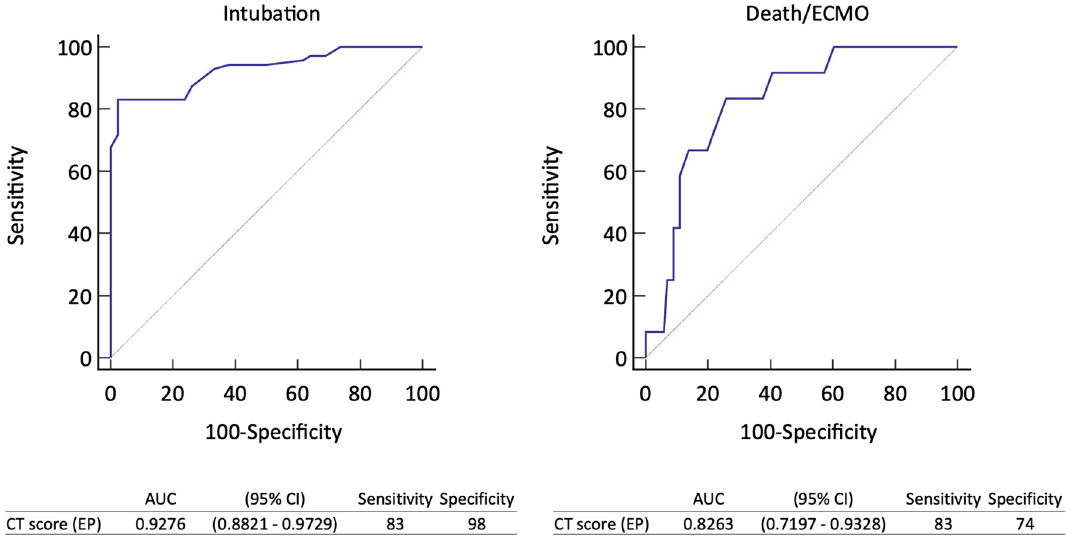
Figure 3. Performance of CT score for predicting intubation and death or ECMO management. The ROC curve shows the emergency physicians’ CT score for predicting intubation and death or ECMO management. AUC, area under the curve; CI, confidence interval; EP, emergency physician.